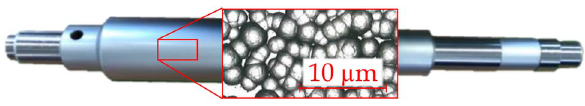
Fig. 3 Micro-structured and hard chrome-plated bottom rollers of the stretch breaking unit